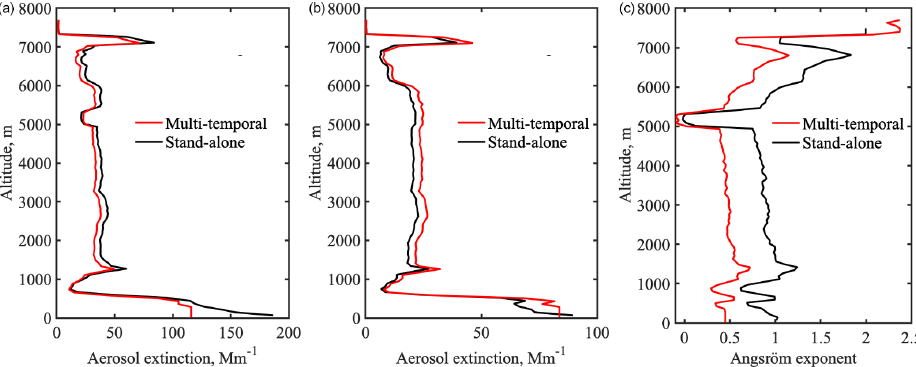
Figure 27. Aerosol extinction profiles at 455nm (a) and 940nm (b) and corresponding Ångström exponent (c) estimated from COBALD profiles acquired on 12 August 2016 using a component (black) and multi-temporal retrieval schemes.